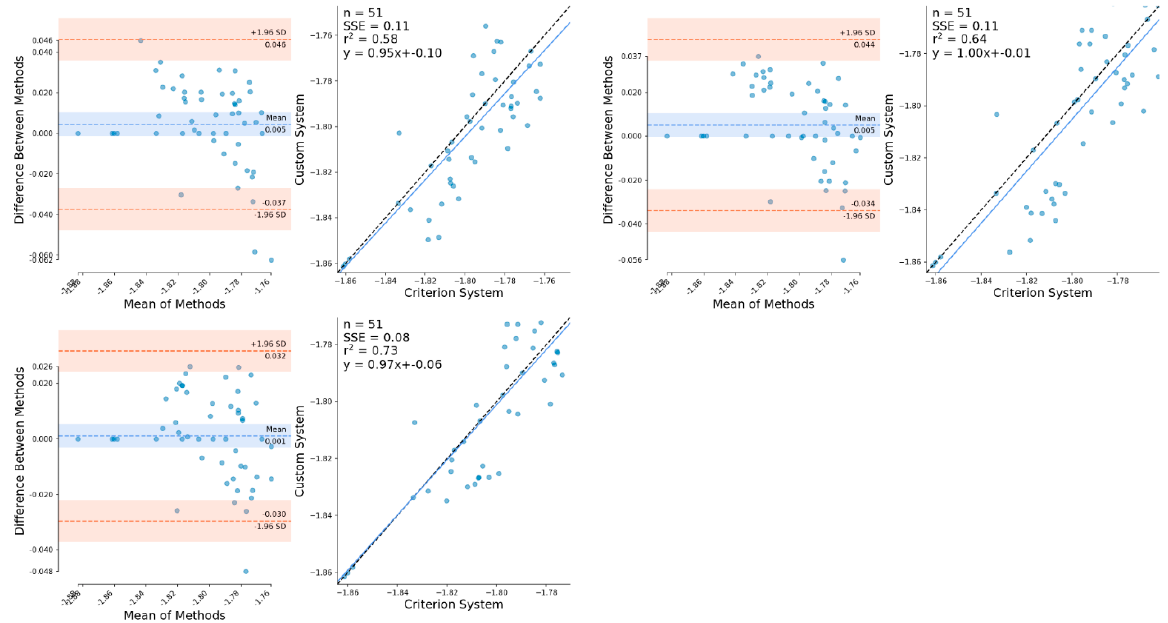
Figure A5. Bland-Altman and linear regression plots demonstrating the differences between OpenPose unfiltered (top- left), low-pass filtered (top-right) and Kalman smoothed (lower-left) CoM horizontal position against marker-based CoM horizontal position during sprinting.